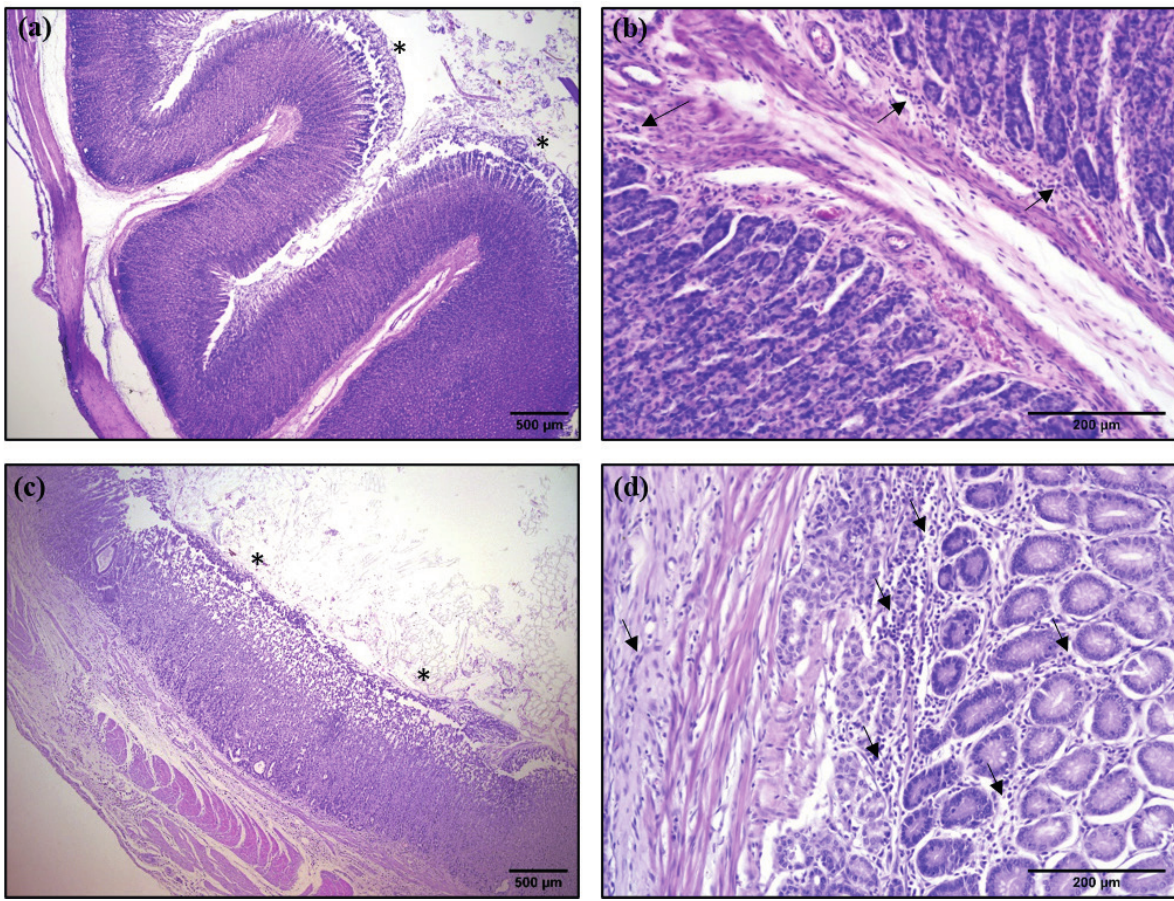
Figure 6. Representative images of 5-μm-thick sections of the glandular region of stomachs of of WD-SHAM (a and b) and WD-VSG (c and d) rats at 3 months after operations; stained with HE. a, shows mild erosion of the mucosa (asterisks) and b, reveals mild and diffuse infl ammatory infi ltrates (arrows) in the mucosa of stomach of WD-SHAM rats. c, shows glandular hypotrophy, intense mucosal erosion (asterisks) and d, demonstrates mild and diffuse infl ammatory infi ltrate in the mucosa and submucosa (arrows), as well as mucosal edema in the stomachs of WD- VSG rats. Scale bars = 200 or 500